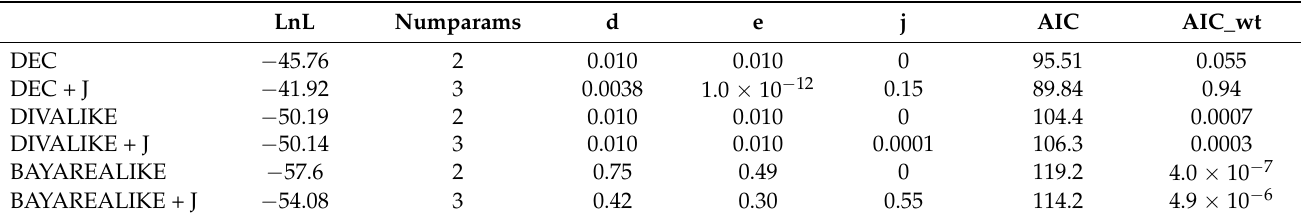
Table 4. Results of the biogeographic analysis using